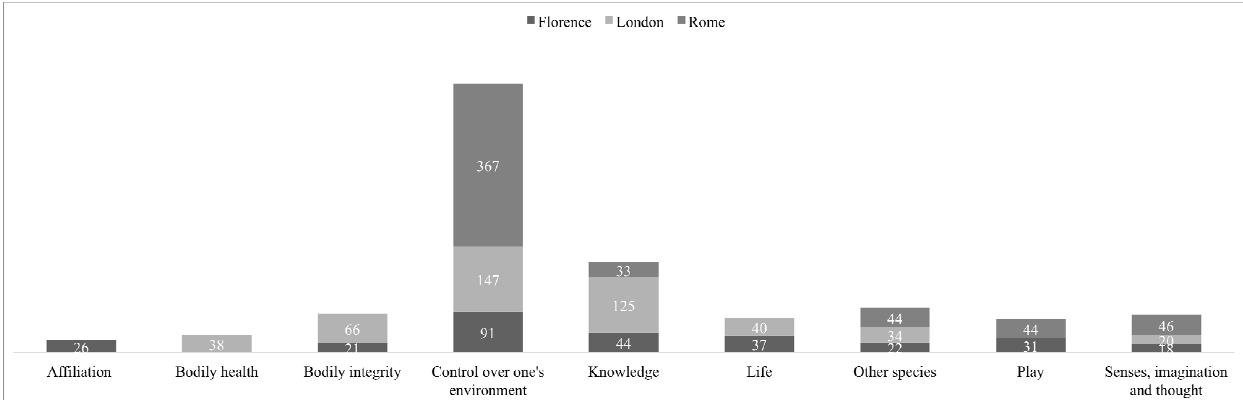
Figure 2. Data sets per capability